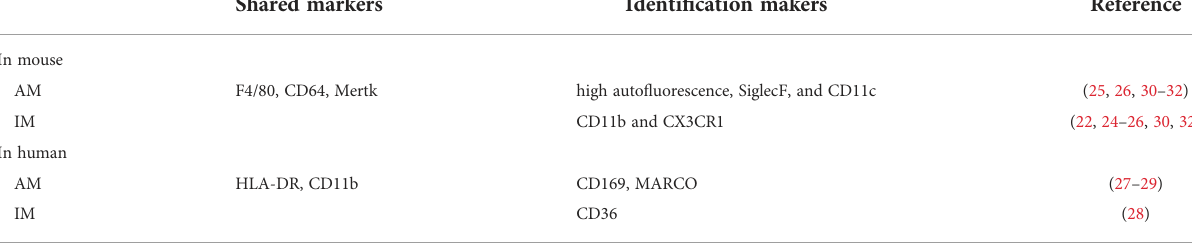
TABLE 1 Identi fi cation markers of AM and IM in steady